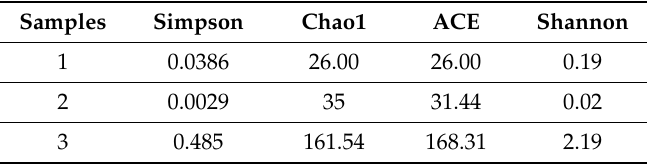
Table 2. Diversity index of fungi